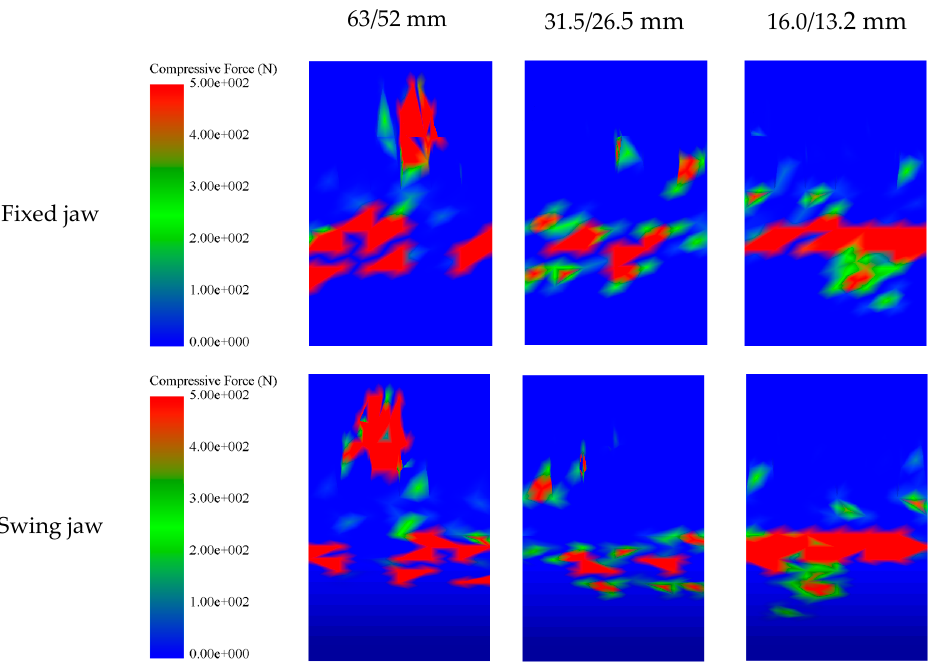
Figure 11. Snapshot of the compressive force on the geometries (fixed and swing jaws) for different feed particle sizes.